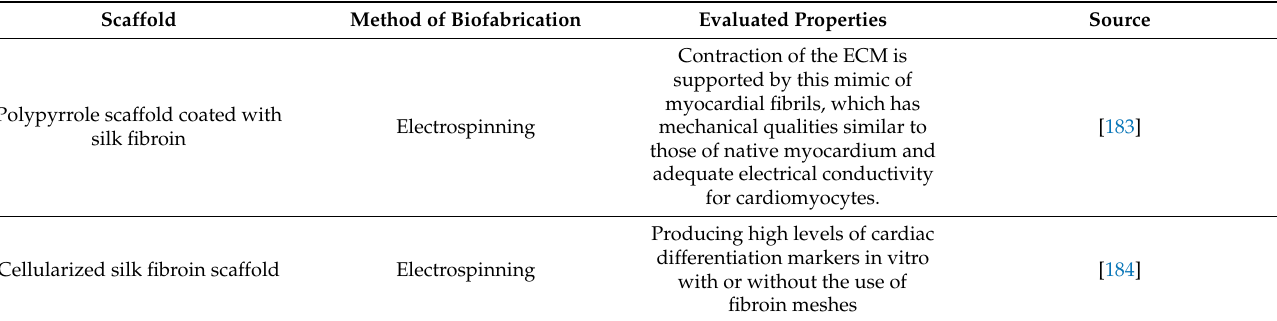
Table 7. Silk-based scaffolds for heart tissue engineering. Scaffold Method of Biofabrication Evaluated